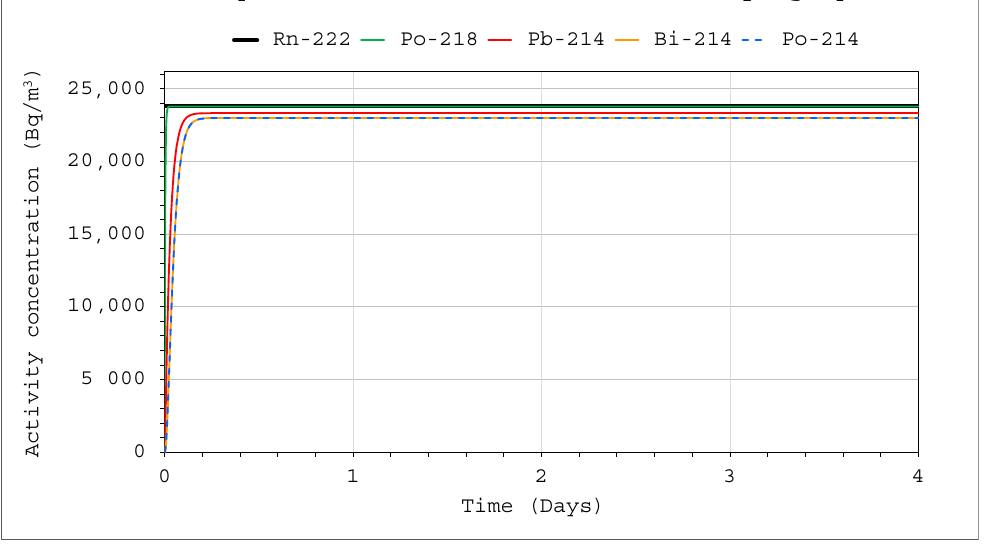
Figure 4. Activity concentration of radon and its progeny inside the system for the following conditions: E 1 = 1 Bq/s (continuously), Q D = 10 L/min (continuously), F = 100%, V = 20 m 3 , C o1 = S 1 / λ 1 , Coi = 0 for i ≠ 1.